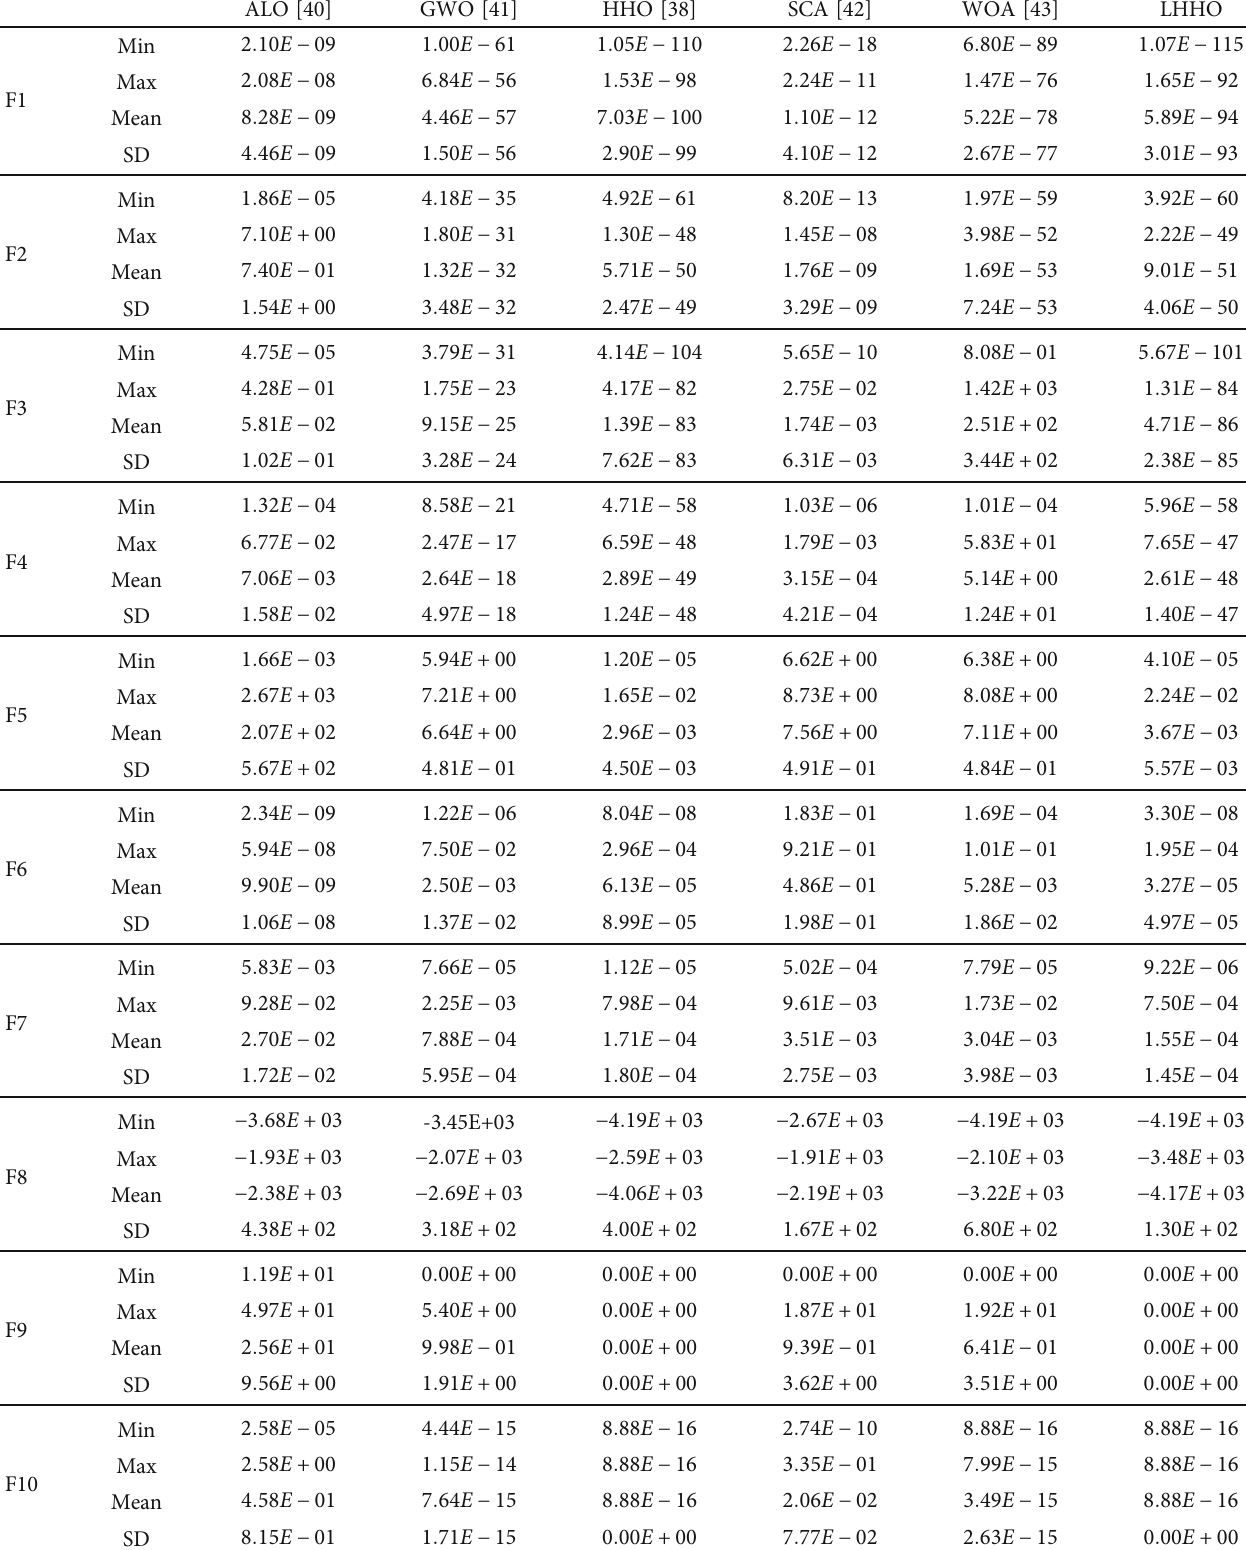
Table 2: Results of conventional benchmark functions